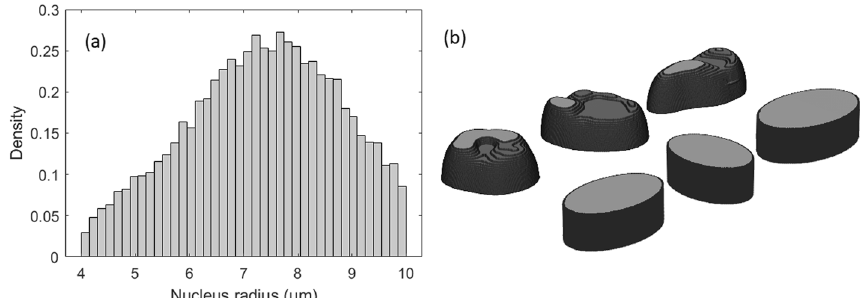
Fig. 2 Distribution of major axis lengths of PC3 cell nuclei in elliptical model ( a ). Measured from segmented DAPI‑stained cell nuclei. Examples of cell phantom models ( b ). Elliptical cylinder phantoms (front row) generated from the axis lengths in ( a ). Examples of segmented 3D volumes (back row) from confocal imaging of DAPI‑stained